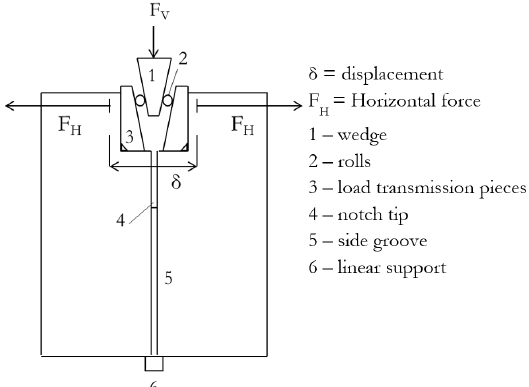
Figure 3. Test arrangement: fracture zone between points 4 and 6; horizontal pieces for application wedge with devices 1 and 3; 5 represents the height of the face initially